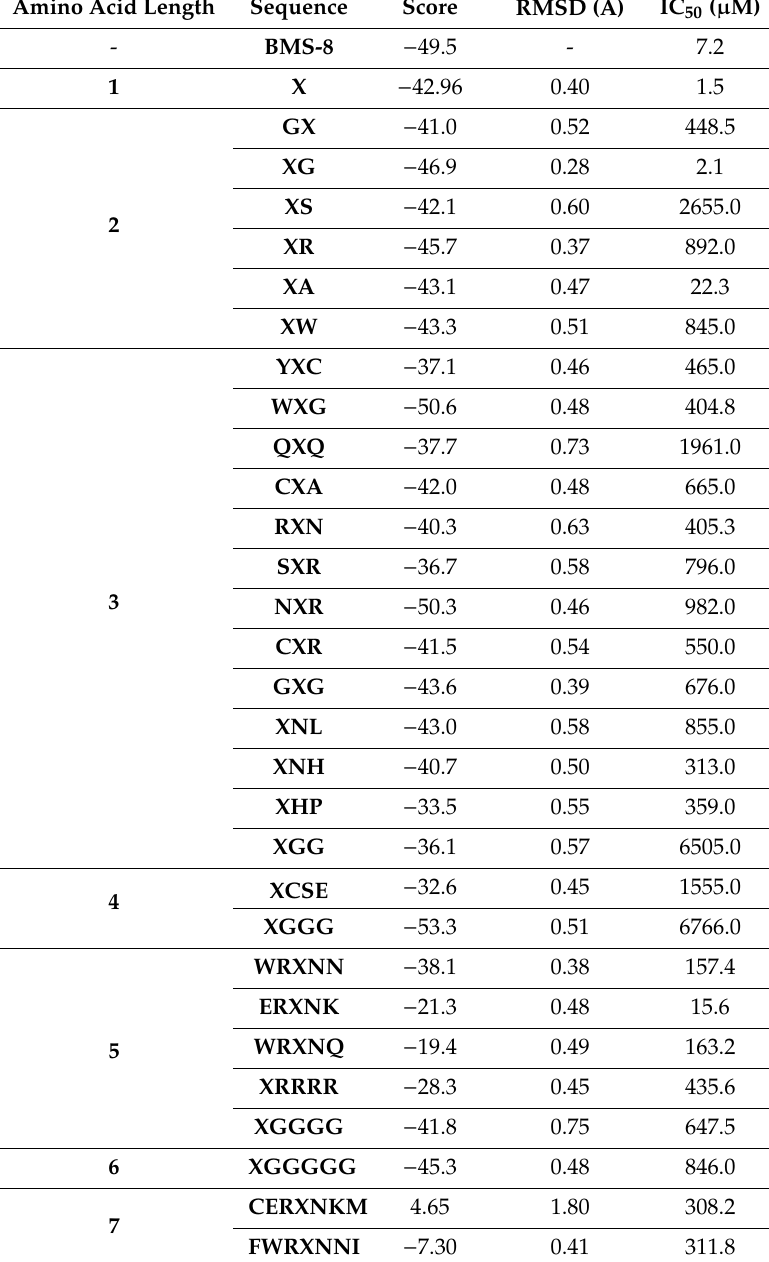
Table 1. Docking simulation and IC 50 measurements of BMS-8 and amino-X s. Amino Acid